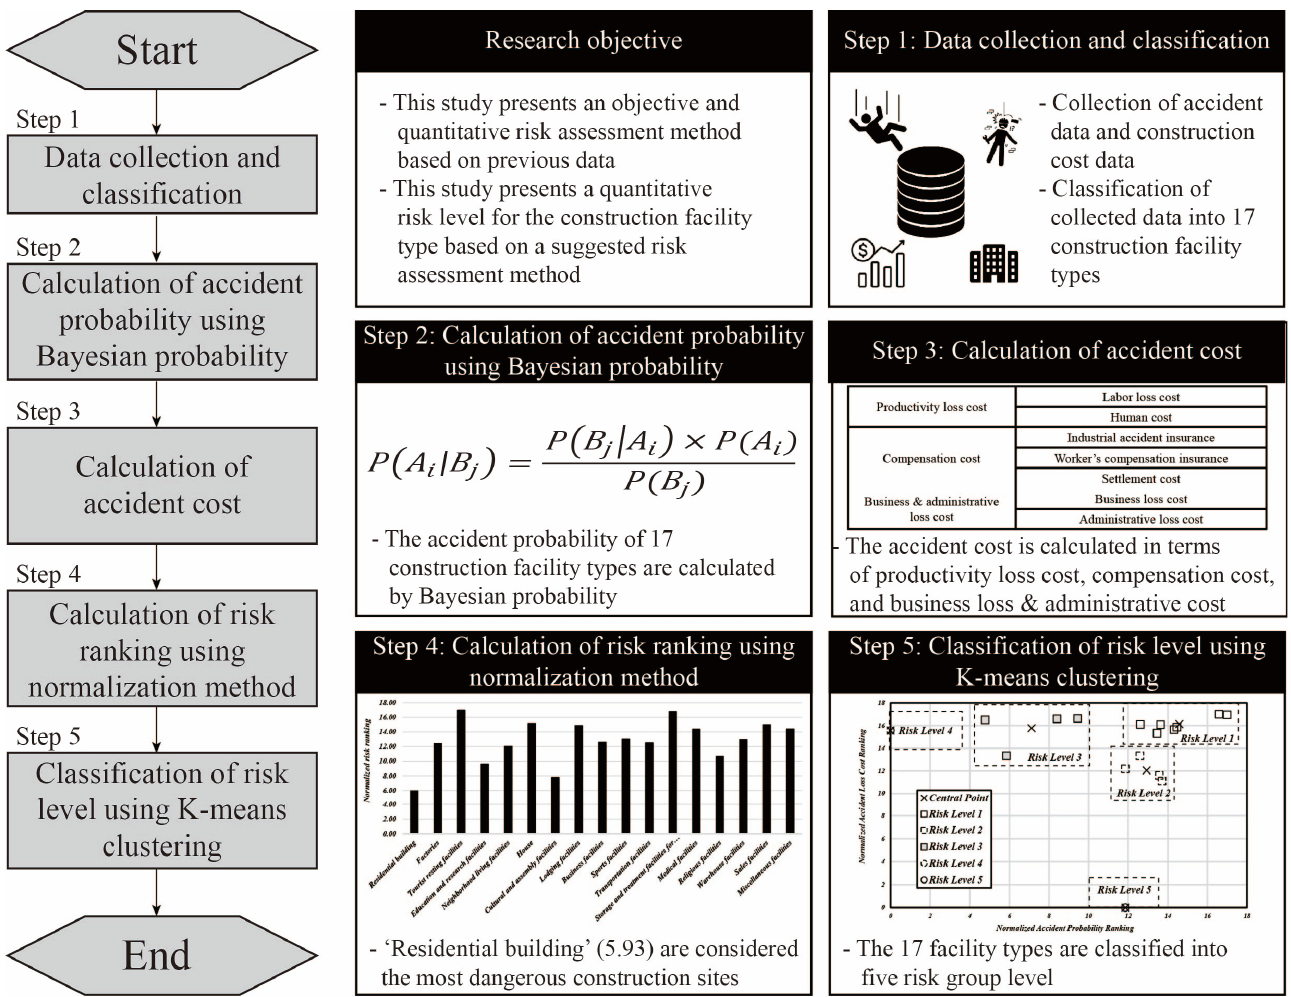
Figure 1. Research process.